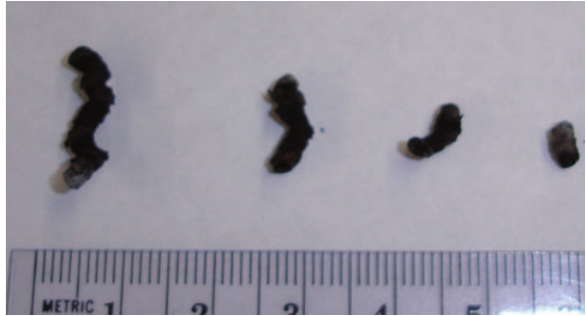
Figure 4 Carbon nanotube-rich deposit production: time vs.